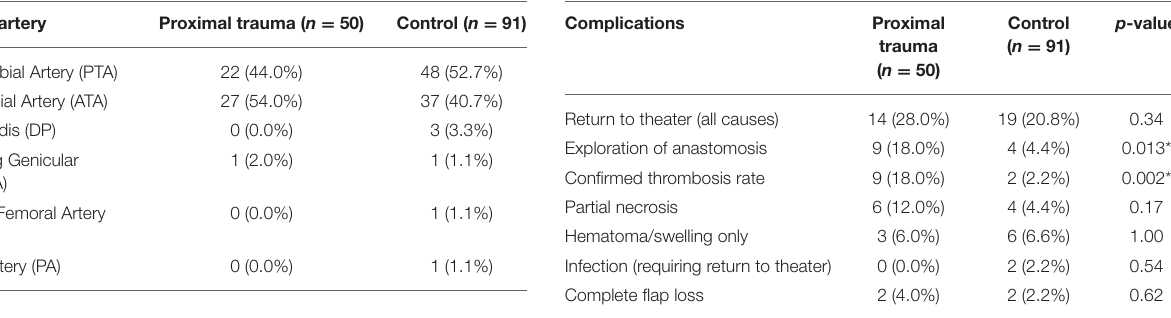
TABLE 6 | Complication rates between proximal trauma group and control